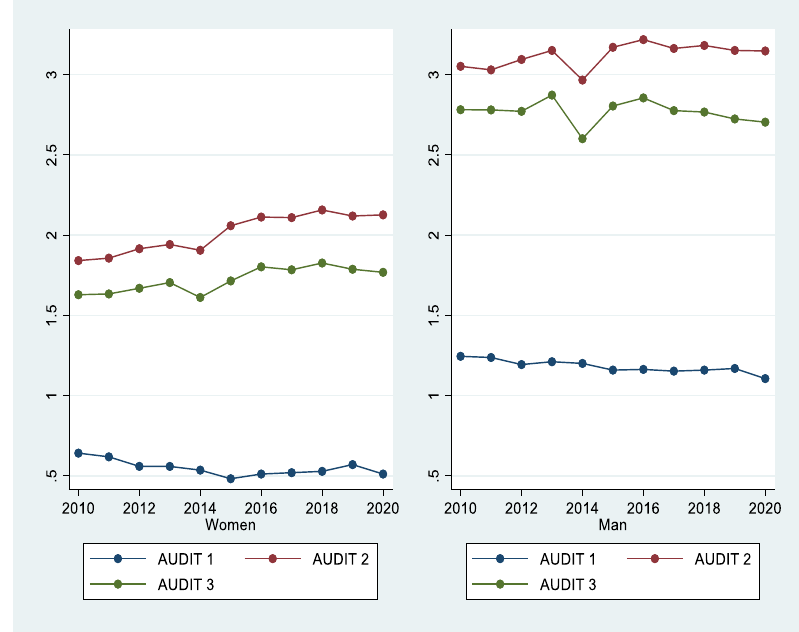
Figure 3. Trends of the AUDIT 1, 2, and 3 items from 2010 to 2020.